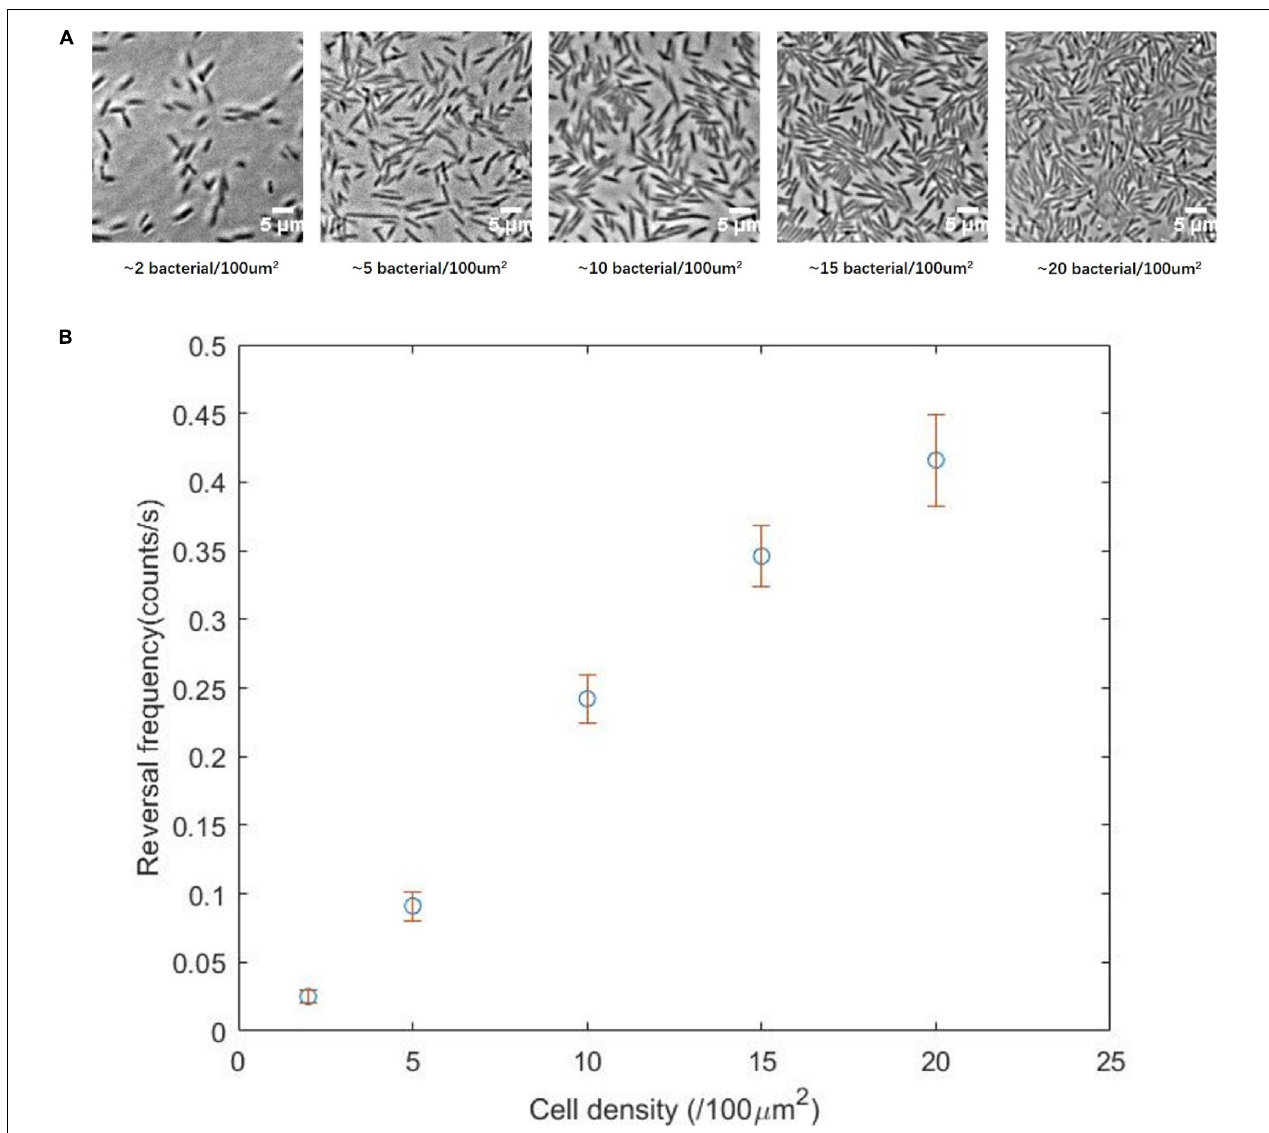
FIGURE 4 | (A) Two-dimensional movement of the (cid:49) cheY strain at different cell density, showing the transition from single-cell state to normal swarming state. (B) Reversal frequency as a function of the cell density, showing a clear correlation between the two parameters.